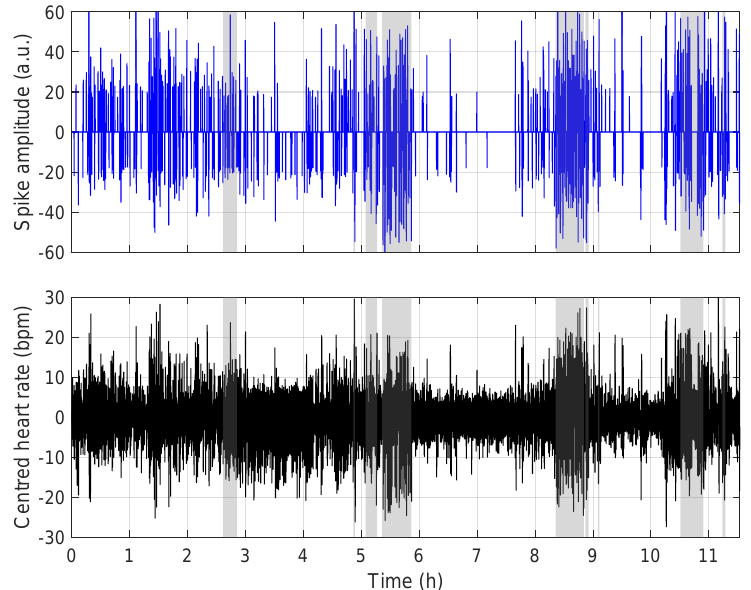
Figure 14. PhysioNet: recording “X-10”, an example where our model over-estimates AHI. The same representation as in Figure 9; the heart rate variability is high for this recording; segments of the signal may resemble bradycardia–tachycardia, inducing an overestimation of apnoea while making true events less